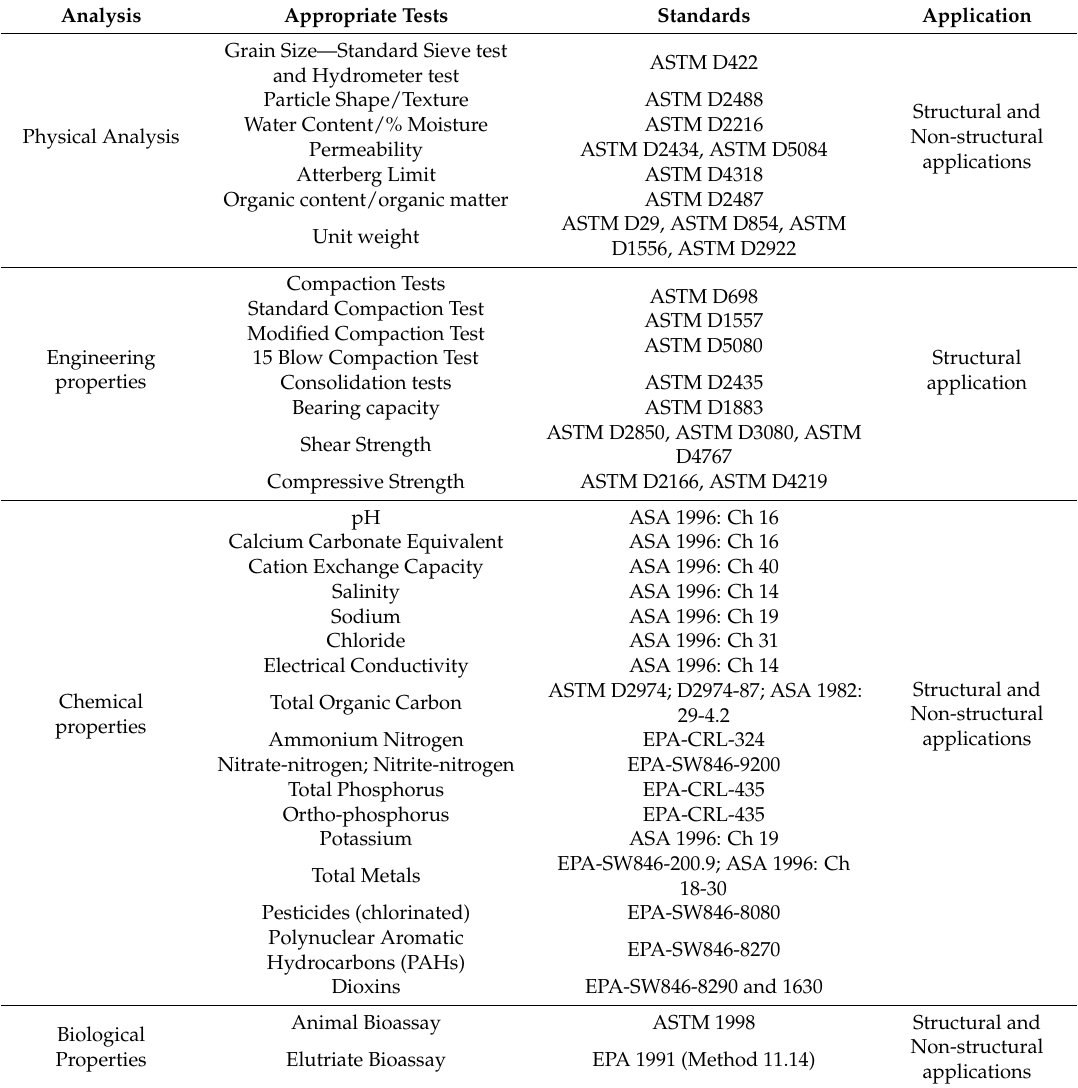
Table 1. Appropriate tests for determining physical, engineering, chemical, and biological properties of dredge material to evaluate its suitability in the built environment (Ref: